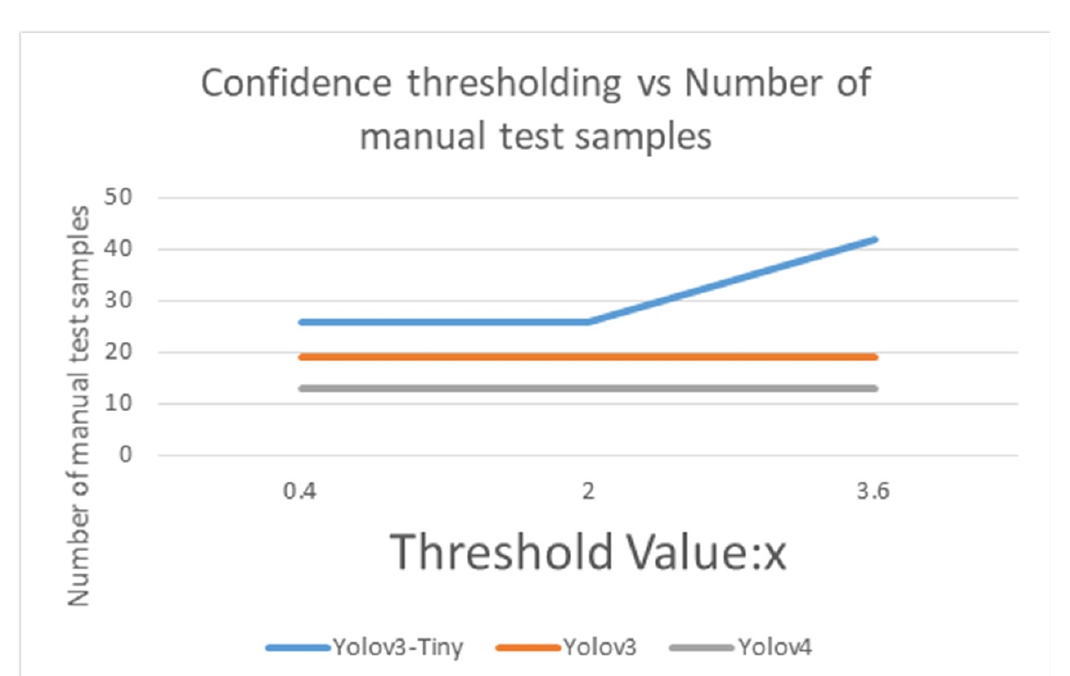
Figure 16. Confidence thresholding vs. Number of manual test samples by using Yolov3-Tiny, Yolov3 and Yolov4.